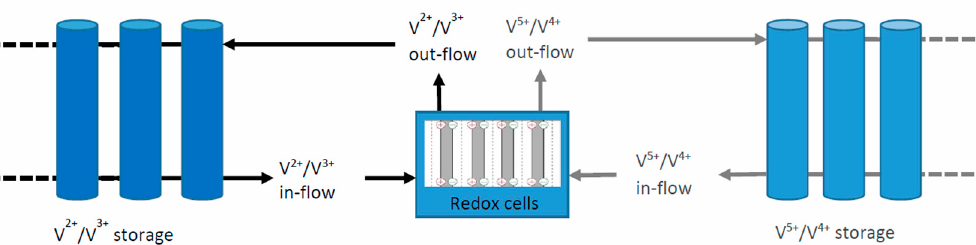
Figure 3. Schematic diagram of a Vanadium Redox Flow Battery with extendable and disconnectable electrolyte storage tanks.